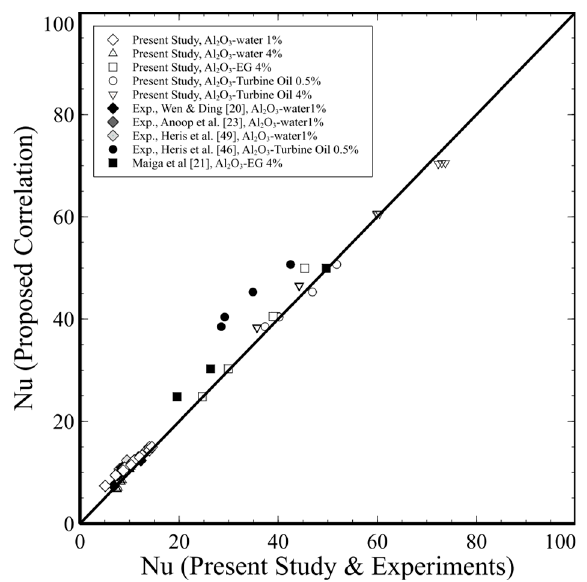
Figure 8. Proposed correlation vs computed results and experiments of Nu in a straight tube.